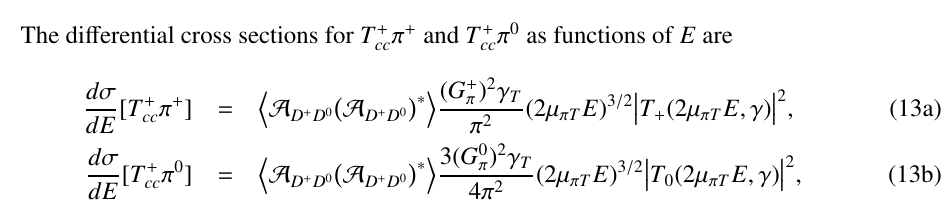
Figure 2. Di ff erential cross sections d σ [ T + π + ] / dE divided by σ [ T + , no π ] as cc cc functions of the invariant kinetic energy E . The four cases of ( | ε T | , Γ ∗ + ) in order of increasing height of the peak are (a) (360 keV, 83 keV) (blue curve), (b) (360 keV, 0) (purple curve), (c) (0, 83 keV) (red curve), and (d) (0, 0) (black curve). The vertical dotted line is at the limiting triangle-singularity energy E lim . The scale △ + on the vertical axis is